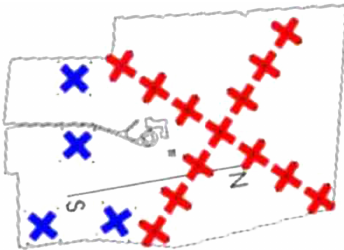
Figure 44. Mills cross MF antenna (red).